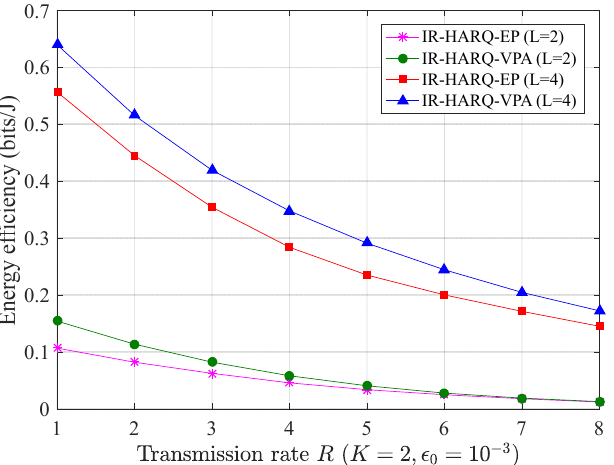
Figure 7. The energy efficiency of IR-HARQ-EP and IR-HARQ-VPA schemes with K = 2 and (cid:101) = 10 − 3 under different values of R .